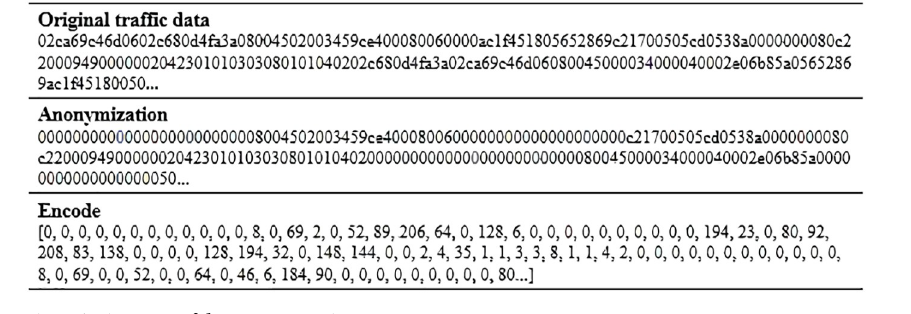
Fig 4. An instance of data